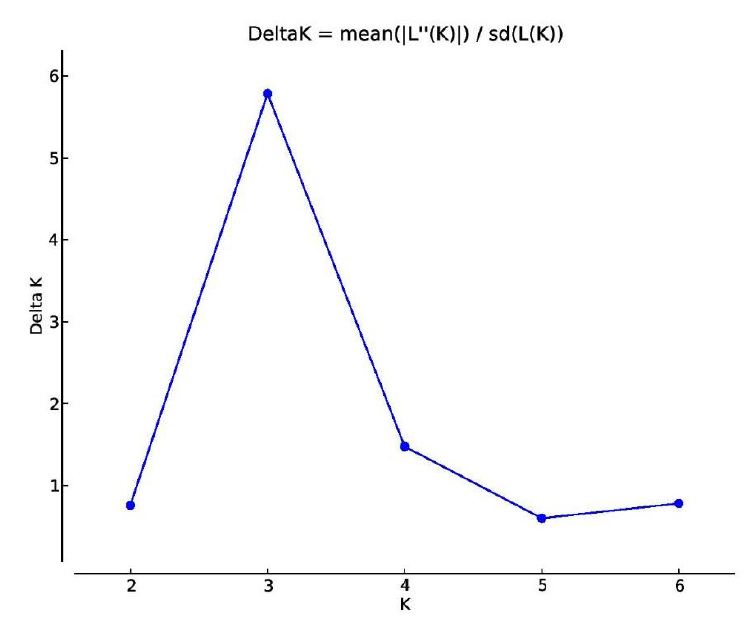
Figure 5. Delta K for the entire safflower population indicating the presence of three subpopulations at K = 3.